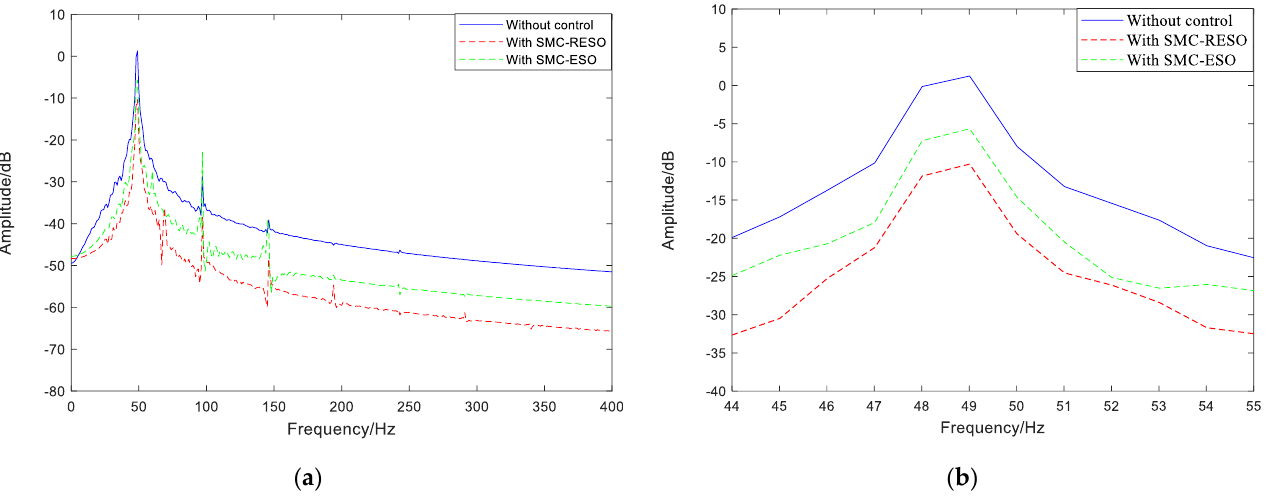
Figure 5. Time domain response.